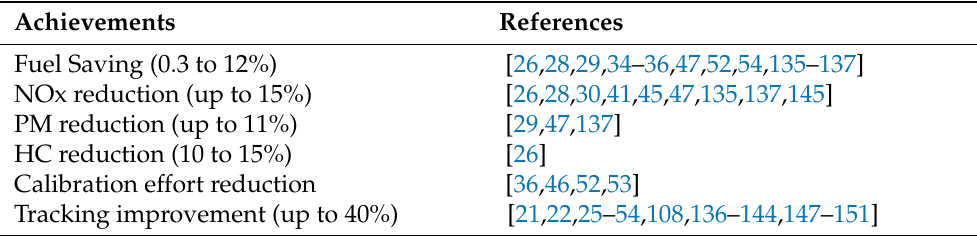
Figure 15. Performance of multi-linear MPCs to track desired load (IMEP) and combustion phasing (CA50) by adjusting injected fuel quantity (FQ), start of injection (SOI), and dual fuel premixed ratio (PR) for a four-cylinder RCCI engine. ( a ) Tracking of reference load (IMEP), ( b ) Tracking of reference combustion phasing (CA50), ( c ) SOI control action, ( d ) PR control action, ( e ) FQ control action, and ( f ) cyclic variability of IMEP (Reprinted from [27] with permission of Elsevier). Table 5. Summary of the main accomplishments of articles reviewed about MPC in ICEs in compari- son with conventional control